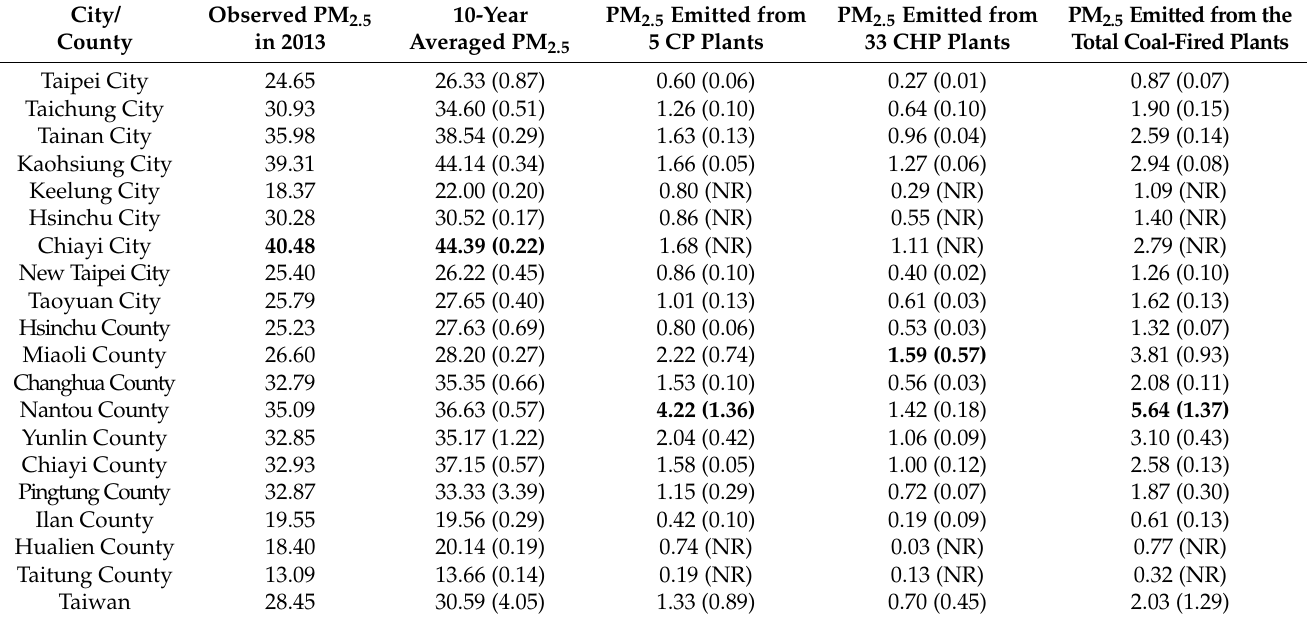
Table 3. City/county based PM 2.5 estimates in different model scenarios with coal